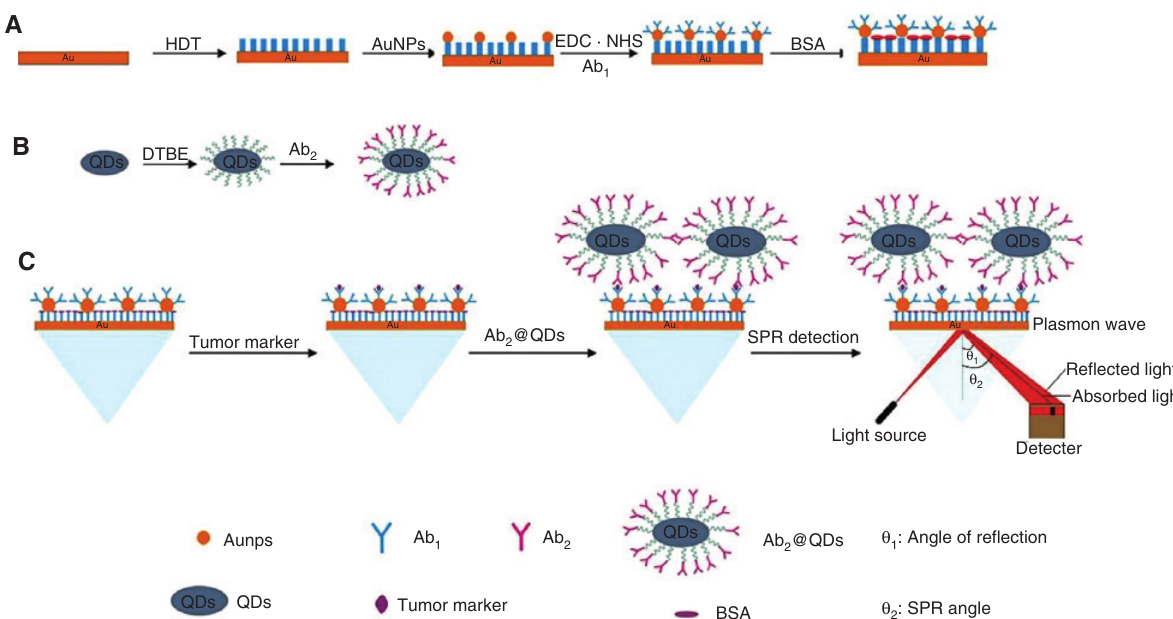
@AuNP 1 @AuNP conjugates to 1